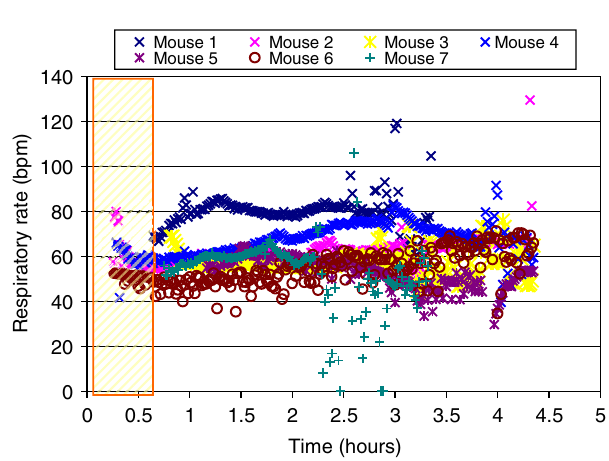
Figure 2. The time course of the respiratory rate of seven individual C57BL/6J mice during in vivo MRI scans (over 4 hours). The rectangle on the left represents the time period which was used for animal positioning, RF coil tuning and acquisitions of anatomical scout images to assure the correct positioning of the mouse brain in the center of the